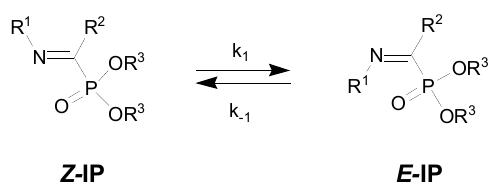
Scheme 1. Z/E isomerization of IPs.